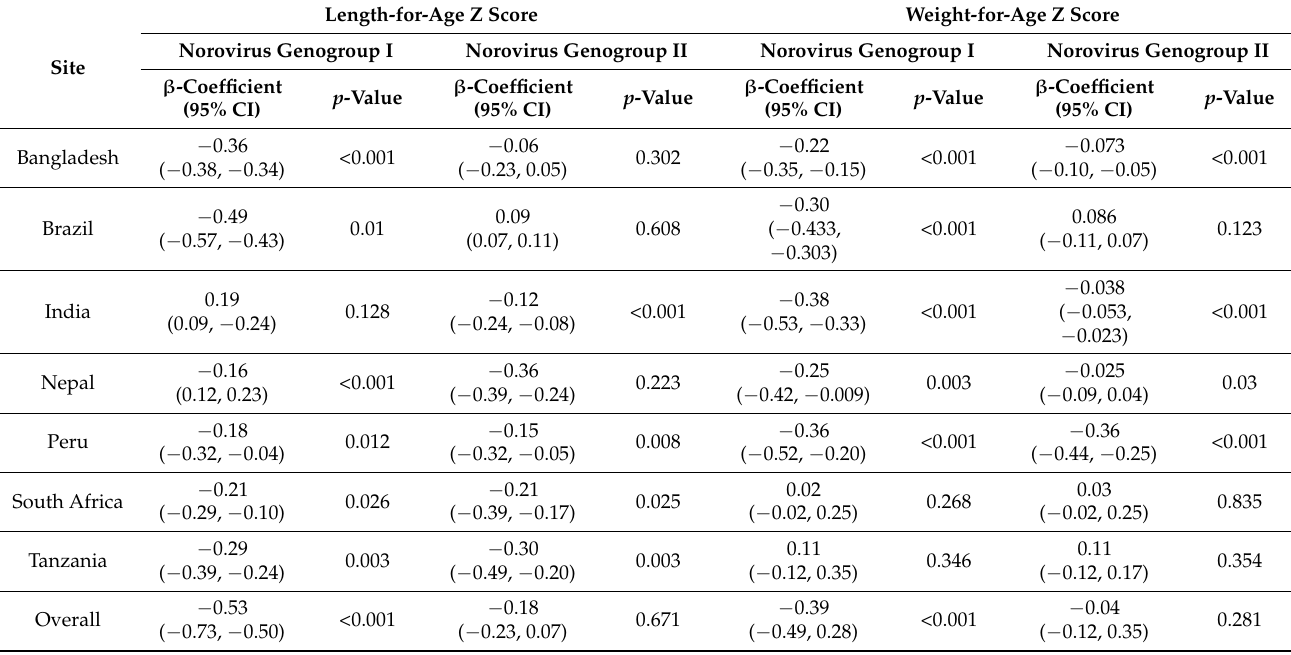
Table 3. Association of infection by norovirus GI and by norovirus GII on linear and ponderal growth of children from enrolment after birth throughout the monthly follow ups until 2 years of